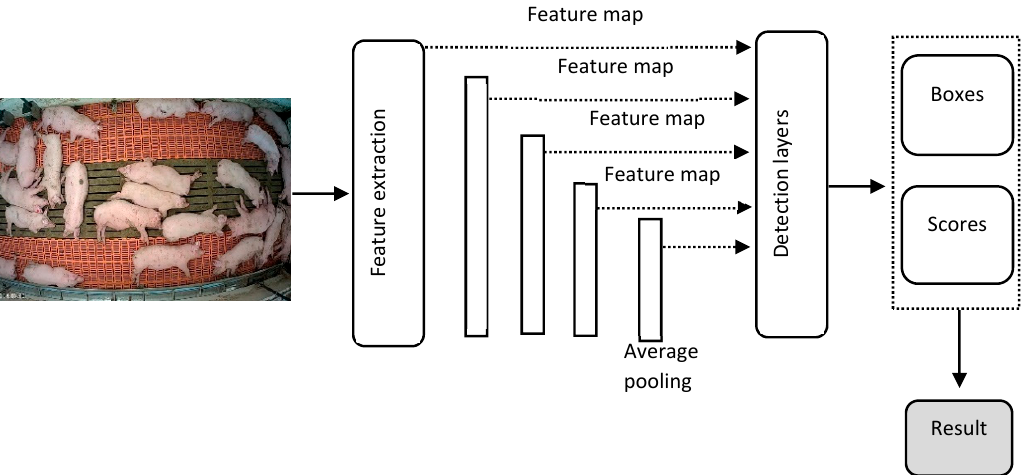
Figure 5. Schematic diagram of the single shot multibox detector (SSD) used in this study. The initial learning rate is a hyperparameter and shows adjustment of weight of the